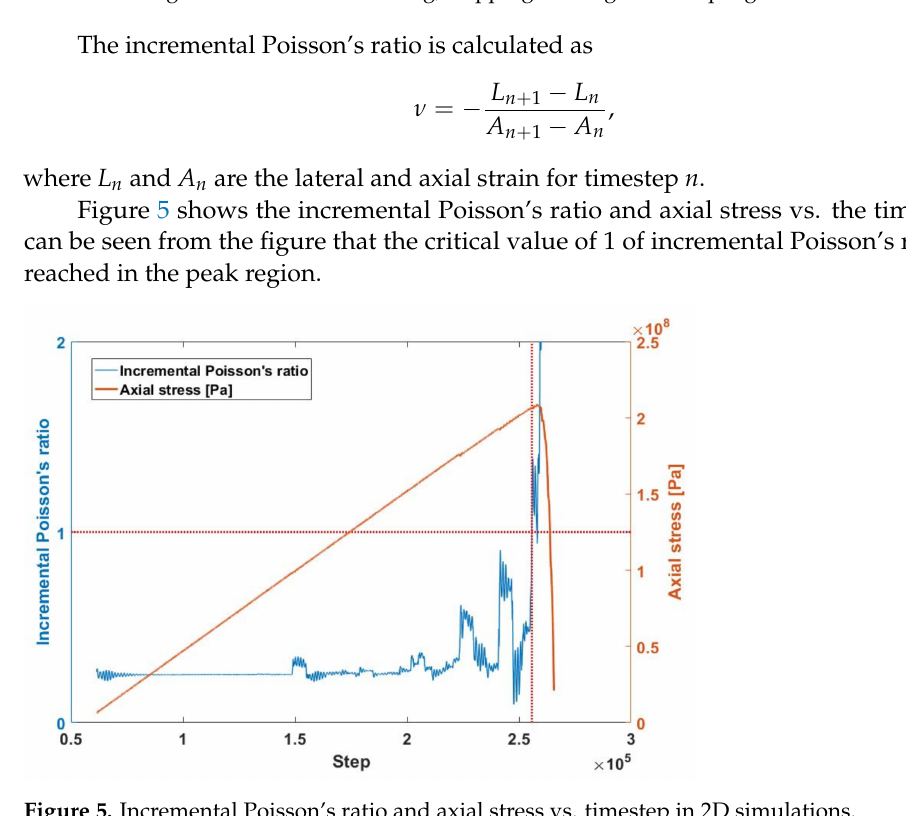
Figure 4. Characteristic time (in computational timesteps) of a full-sized 2D sample. The horizontal axis numbering starts with actual loading, skipping the stages of sample generation and relaxation.